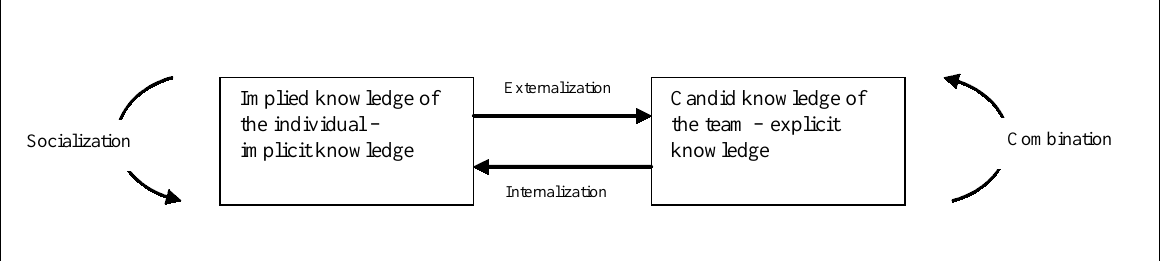
Fig 3. Learning in post-mortem